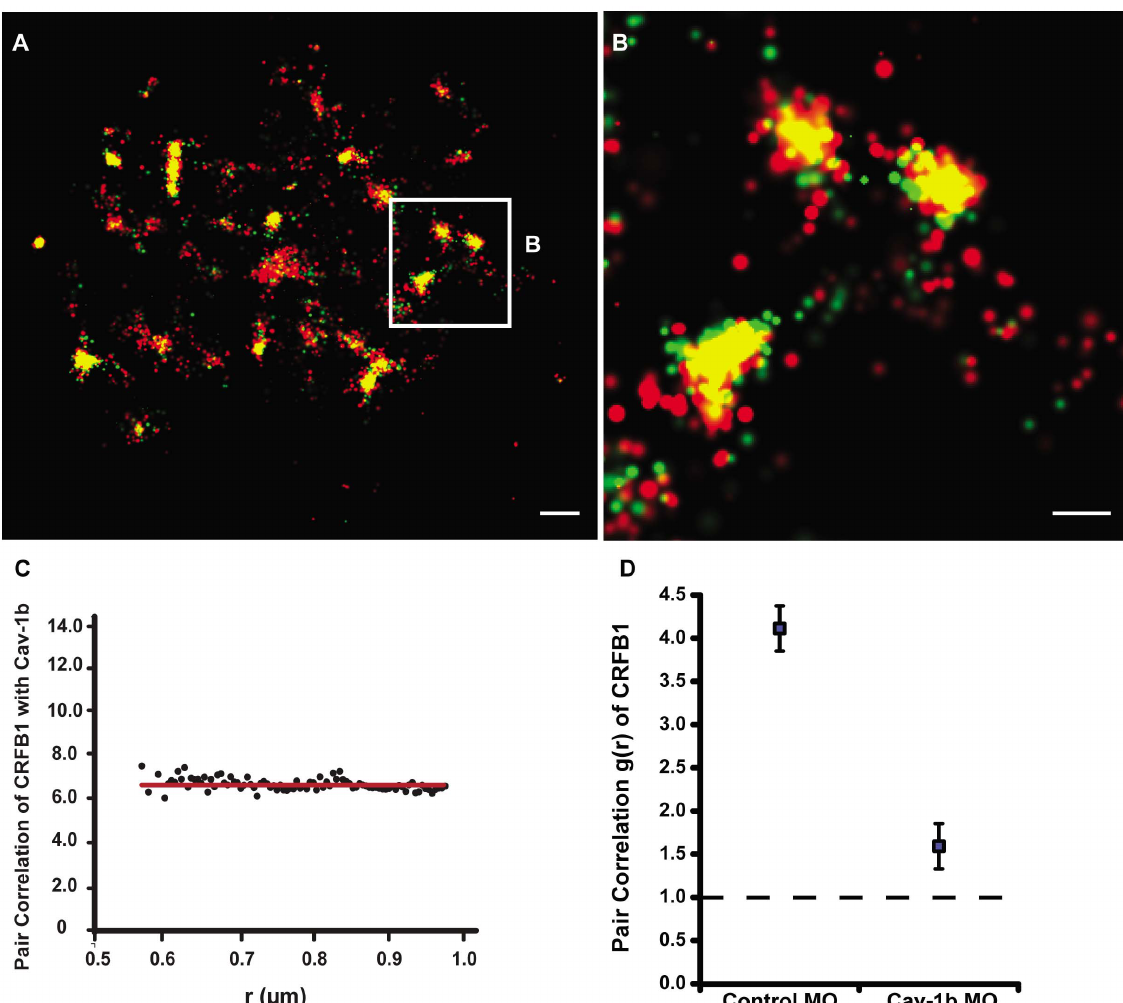
Figure 1. Cav-1b colocalizes with the zebrafish homolog of IFN-R and is positively correlated. ZFL cells (n $ 10) were transfected with Cav-1b-PAmCherry (red) and with CRFB1-dendra2 (green). For all images, 60 6 /1.2 NA magnification. Scale bars, 1 m m. Shown is the plasma membrane of one cell representative of the experiment ( A ) and a magnification ( B ) of the region marked by the white box in A. The image shows that Cav-1b and CRFB1 colocalize in the cell membrane. ( C ) Measurements of Cav-1b and CRFB1 show a positive pair correlation value g(r) greater than one, confirming that the two species are colocalized together. Pair correlation calculations were performed as described in Methods; briefly, g(r) . 1 indicates positive correlation/clustering, and g(r)=1 indicates a random distribution. ( D ) Pair correlation measurements of CRFB1 were calculated for the receptor, control morpholino (MO), and Cav-1b MO. CRFB1 is more prone to random distribution when Cav-1b is knocked down. Error bars SEM (n $ 8